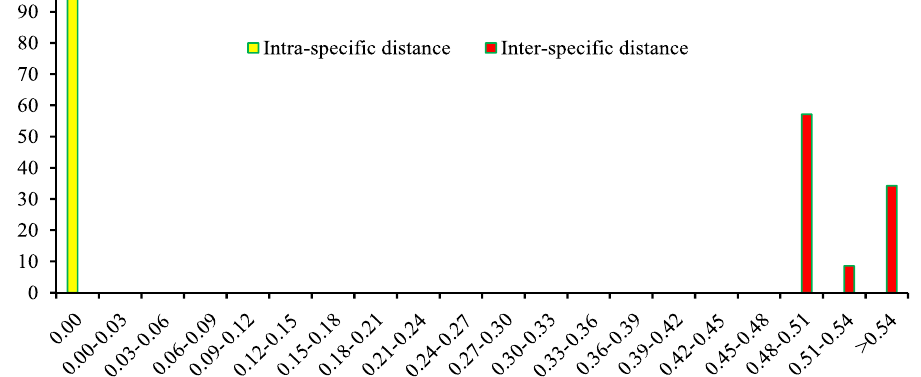
Figure 1. Relative distribution of interspecific divergence between congeneric species and intraspecific distances for ITS2 locus.